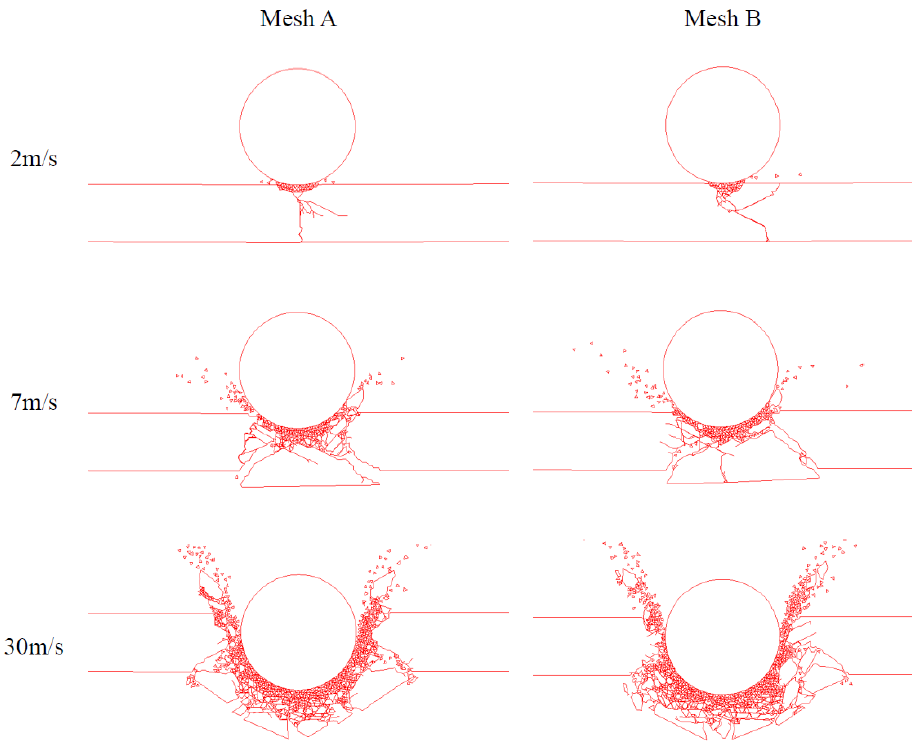
Figure 12. Damage patterns of the glass with different meshes at t = 1 ms.